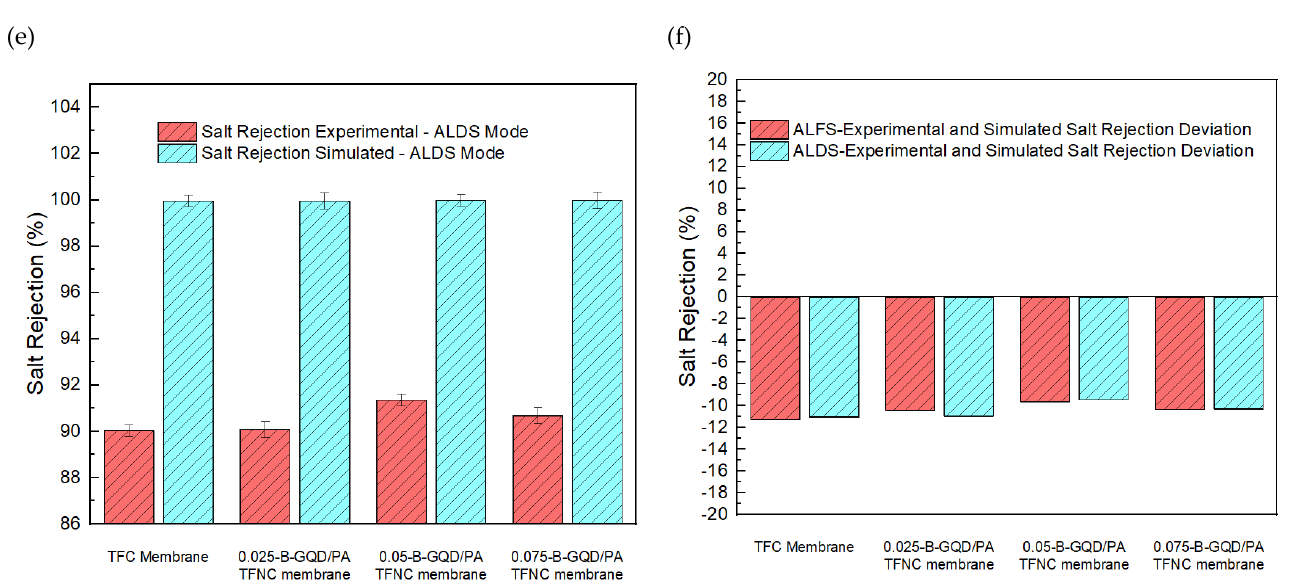
Figure 15. ( a ) AL-FS mode experimental and simulated SRSF; ( b ) AL-DS mode experimental and simulated SRSF; ( c ) AL-FS and AL-DS mode experimental and simulated SRSF percentage deviation; Figure 15. ( a ) AL − FS mode experimental and simulated SRSF; ( b ) AL − DS mode experimental and ( d ) AL-FS mode experimental and simulated salt rejection; ( e ) AL-DS mode experimental and simulated SRSF; ( c ) AL − FS and AL − DS mode experimental and simulated SRSF percentage devia- simulated salt rejection; ( f ) AL-FS and AL-DS mode experimental and simulated salt rejection tion; ( d ) AL − FS mode experimental and simulated salt rejection; ( e ) AL − DS mode experimental and percentage simulated salt rejection; ( f ) AL − FS and AL − DS mode experimental and simulated salt rejection per- centage deviation.